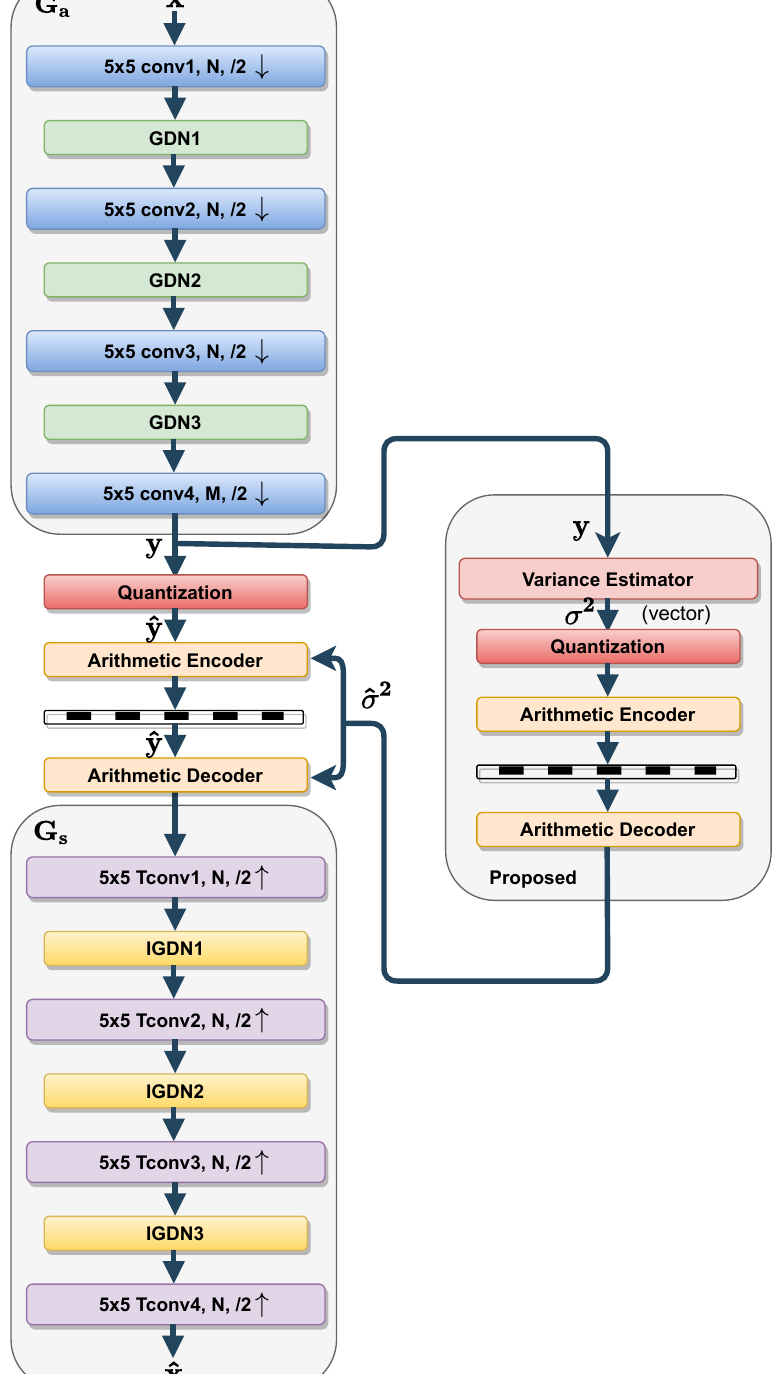
Figure 6. Proposed architecture after entropy model simplification: main autoencoder ( left column ) and simplified auxiliary autoencoder ( right column